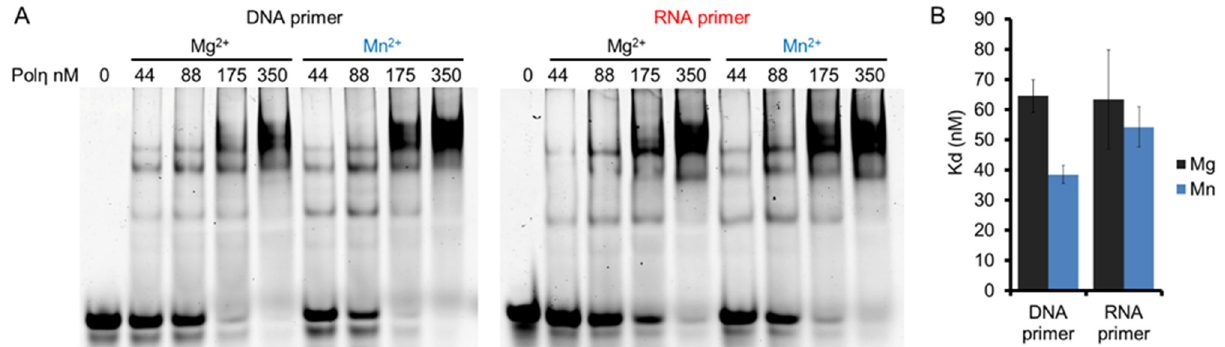
Figure 2. The binding affinity of hPol η to DNA and RNA primers in the presence of Mg 2+ or Mn 2+ . ( A ) DNA/DNA and RNA/DNA primer/templates (20 nM) were incubated with 0 to 350 nM hPol η as indicated, in the presence of 4 mM Mg 2+ or Mn 2+ . Complexes were resolved on a 4% non-denaturing polyacrylamide gel. ( B ) Quantitation of binding affinities. 10 nM of DNA/DNA or RNA/DNA was incubated with hPol η (from 22 to 175 nM in 11 increments). The standard deviation (SD) for each substrate is indicated.